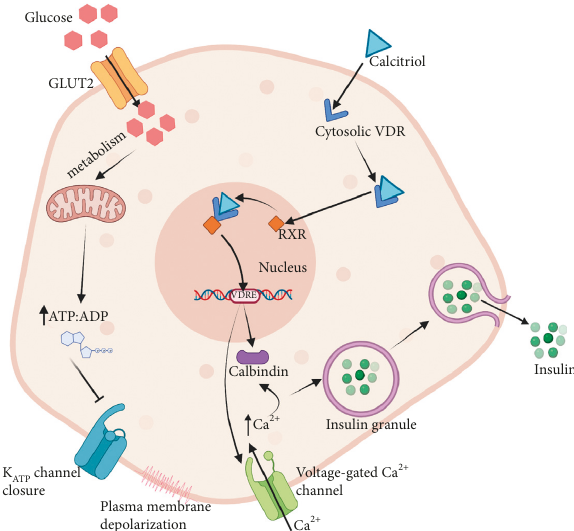
Figure 1: The mechanism underlying glucose-stimulated insulin secretion in pancreatic β -cell. Glucose is transported into the cell via GLUT2. Glucose metabolism leads to a high ATP: ADP ratio, which triggers the closure of ATP-sensitive potassium channel (K ATP channel). The resulting plasma membrane depolarization stimulates the opening of the voltage-gated calcium channels (VGCCs) and calcium influx. High intracellular calcium level induces the exocytosis of the insulin secretory granule and insulin secretion. Vitamin D in its active form calcitriol binds to cytosolic VDR. Calcitriol-VDR complexes are translocated into the nucleus and bind to RXR to form calcitriol-VDR-RXR complexes. These complexes then bind to VDRE within the calbindin gene promoter regions to stimulate the transcription of cytosolic calcium-biding proteins, calbindins. calbindins regulate cytosolic calcium con- centration and indirectly modulate calcium-dependent insulin secretion. Here, vitamin D also indirectly upregulates the Vgcc genes and thus could help to enhance calcium influx through